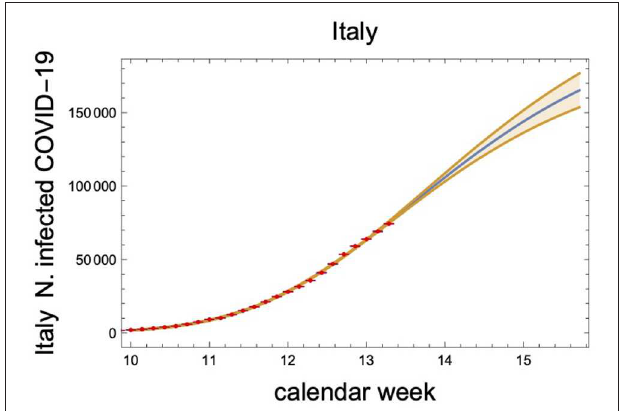
FIGURE 10 | COVID-19 infected cases in Italy as function of the calendar week number. The curve and the band (90% confidence level) have been obtained by performing a fit w.r.t. a , b , and γ to the red data